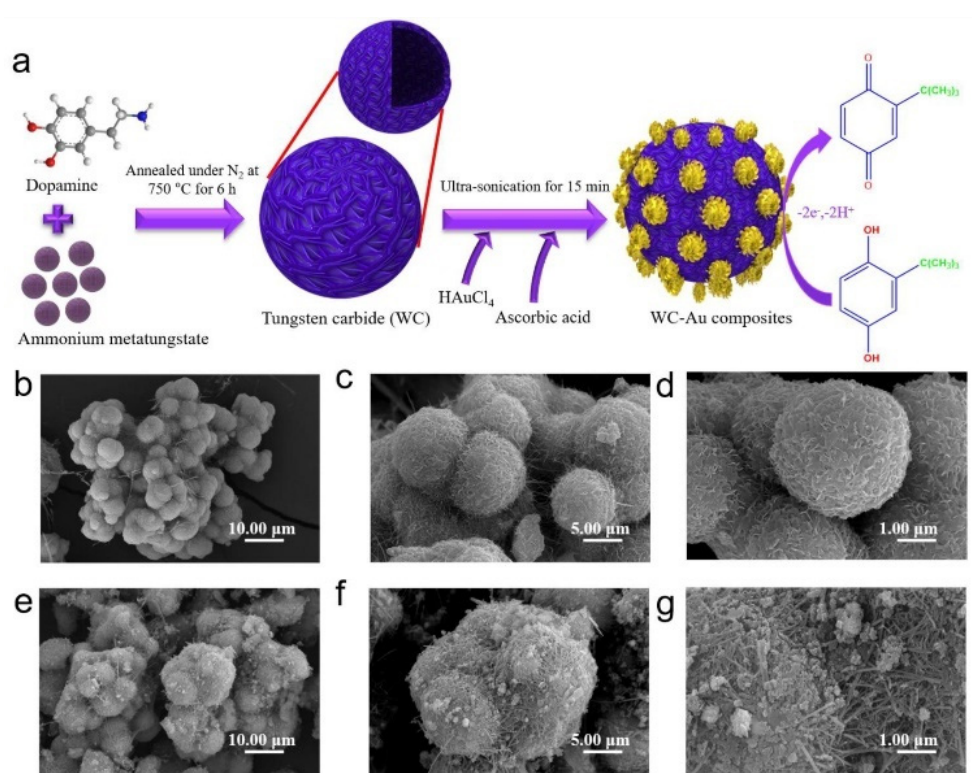
Figure 26. ( a ) Schematic representation of the AuNP-WC composite synthesis and of TBHQ oxidation mechanism. SEM images of ( b – d ) WC and ( e – g ) AuNP-WC at different magnifications. Reprinted with permission from [194]. Copyright 2021, Elsevier.